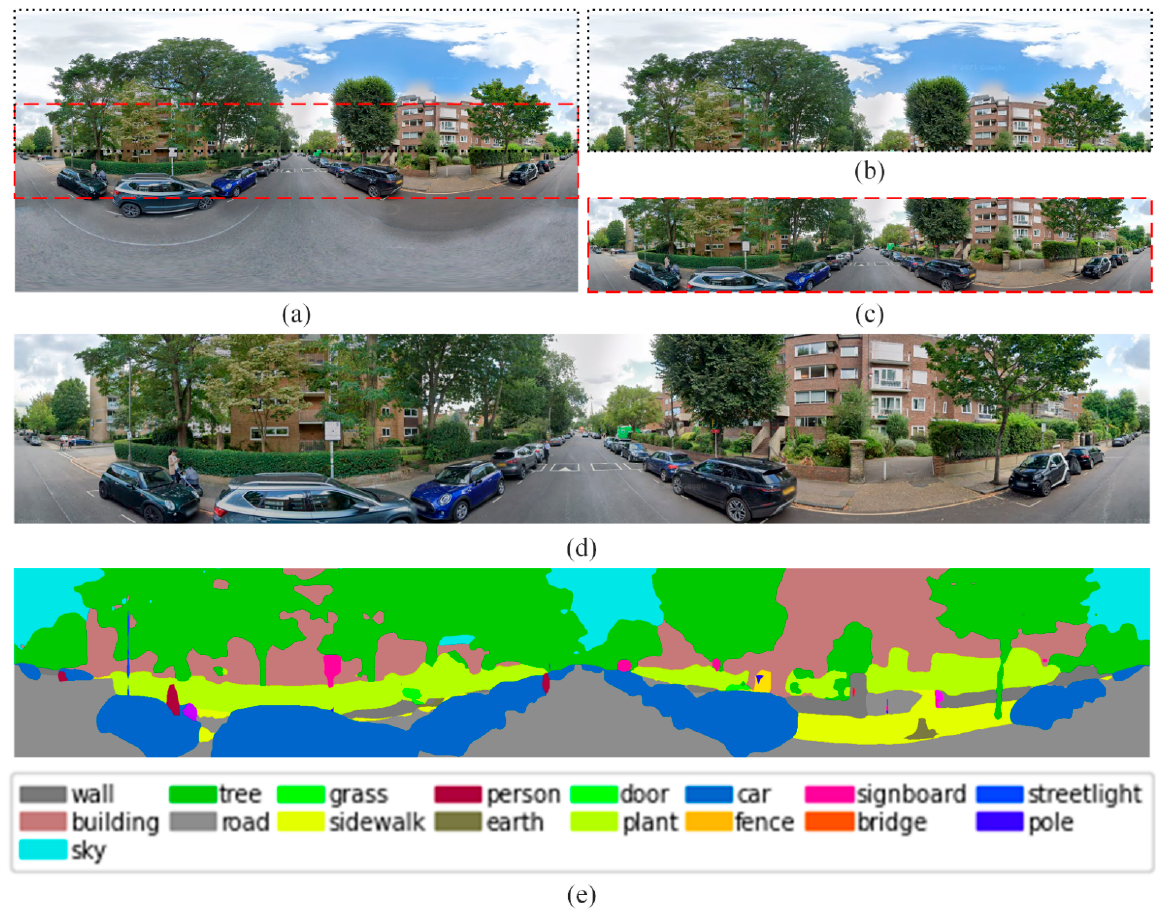
Figure 4. Semantic segmentation based on PSPNet. ( a , c , d ) The part within the red dotted line is the part where we extracted the street ‐ level built environment characteristics; ( a , b ) the part within the black dotted line is where we used to calculate SVF values; ( e ) the result of semantic segmentation. (3) Calculate the sky view factor. SVF is an important indicator to evaluate the openness